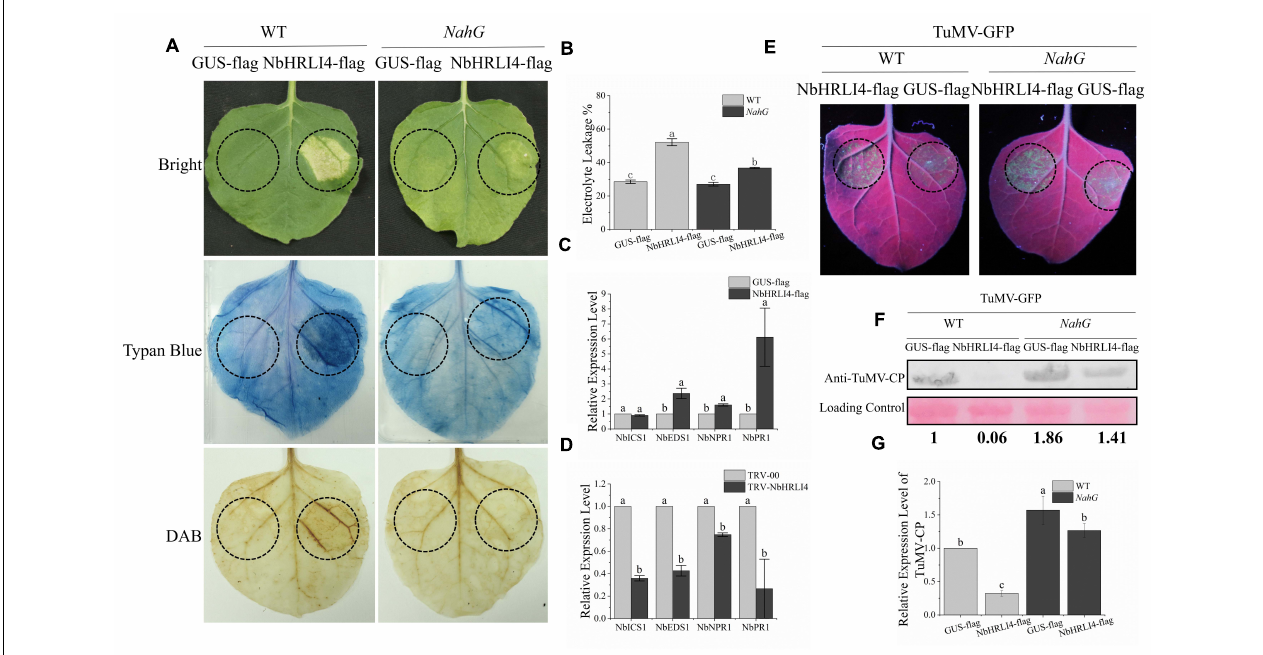
FIGURE 5 | NbHRIL4 induced HR-like cell death in an SA-dependent manner. (A) Overexpression of NbHRLI4 (but not GUS) induced cell death (confirmed by trypan blue staining) at 6 dpi. H 2 O 2 accumulated significantly in areas expressing NbHRLI4 as shown by DAB staining. Overexpression of NbHRLI4 induced less cell death at 6 dpi on NahG plants. (B) NbHRLI4-flag and GUS-flag were overexpressed in both WT and NahG plants. Leaf disks were excised and assayed for electrolyte leakage at 6 dpi. (C) Results of RT-qPCR showing the expression levels of NbEDS1 , NbICS1 , NbNPR1 , and NbPR1 in WT plants overexpressing NbHRLI4-flag or GUS-flag at 3 dpi. (D) Results of RT-qPCR showing the expression levels of NbEDS1 , NbICS1 , NbNPR1 , and NbPR1 in WT plants infected with TRV-HRLI4 or TRV-00 at 12 dpi. T -test was used for mean expression values of single gene between two samples in panel (C) and panel (D) . Different letters on histograms indicate significant differences ( P < 0.05). (E) Leaves of WT and NahG plants inoculated with TuMV-GFP and overexpressing NbHRLI4-flag or GUS-flag observed under UV light at 4 dpi. (F) Western blotting detection of TuMV-CP on leaves shown in panel (E) . (G) Results of RT-qPCR to detect TuMV mRNA in leaves shown in panel (E) . The mean expression values in panels (B) and (G) were analyzed using F -test. Different letters on histograms indicate significant differences ( P <